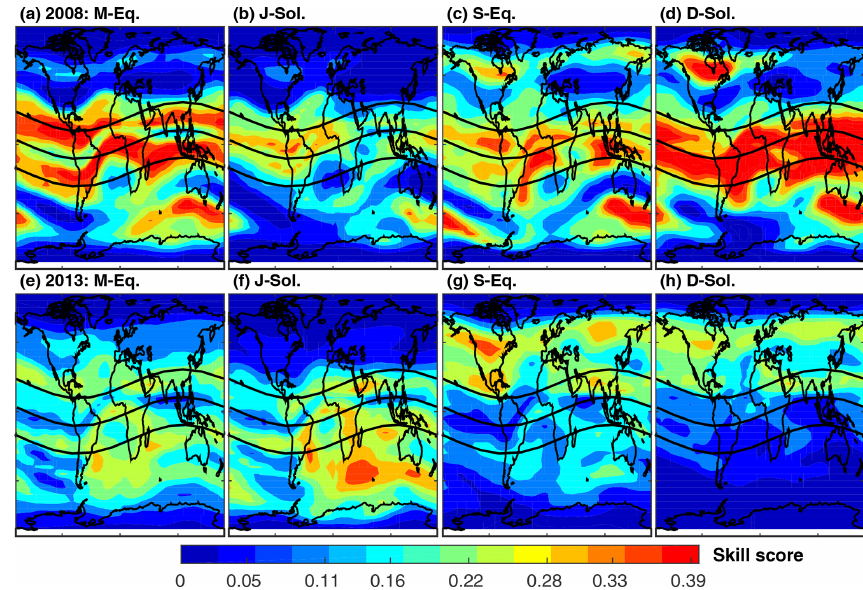
Figure 12. The same as Fig. 9 but for the skill